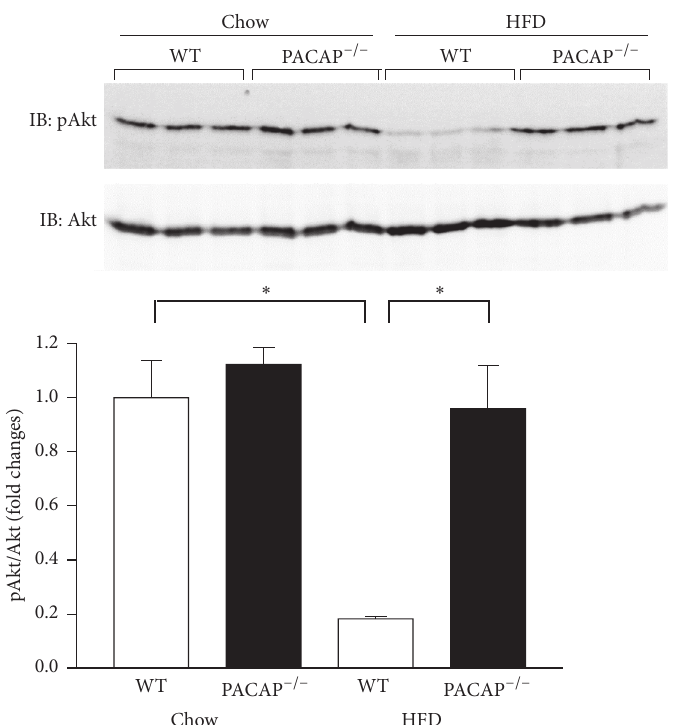
Figure 2: Insulin-induced Akt phosphorylation in liver. Western blot analysis using anti-phospho Akt and anti-Akt antibodies. Liver samples were collected form wild type (WT) and PACAP null (PACAP −/− ) mice fed regular chow and HFD for 6 weeks. The intensity of Akt phosphorylation is expressed by the ratio of phosphorylated over total Akt proteins. 𝑛 = 3 . All data are presented as means ± s.e.m. ∗ 𝑝 < 0.05 .